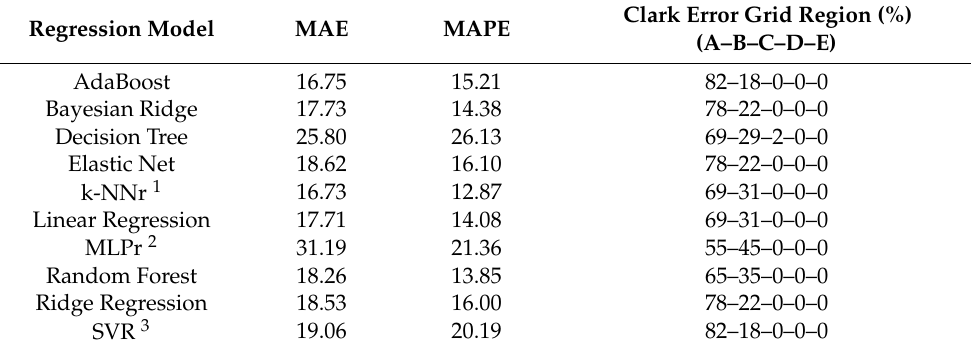
Table 5. Results on the test subset using the first three components of ICA feature extraction. Regression Model